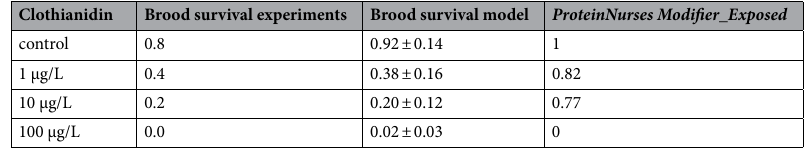
Table 2. Simulation of mating nucleus colonies in BEEHAVE. Modification of the factor ProteinNursesModifier_Exposed in BEEHAVE simulations resulted in brood survival rates similar to experimental data obtained in field experiments. The factor ProteinNursesModifier_Exposed reduces the protein content of the jelly fed to the larvae ( ProteinFactorNurses ) in the model. A wide range of values for ProteinNursesModifier_Exposed was tested, and the best fits are shown based on a comparison of modeled and experimental brood